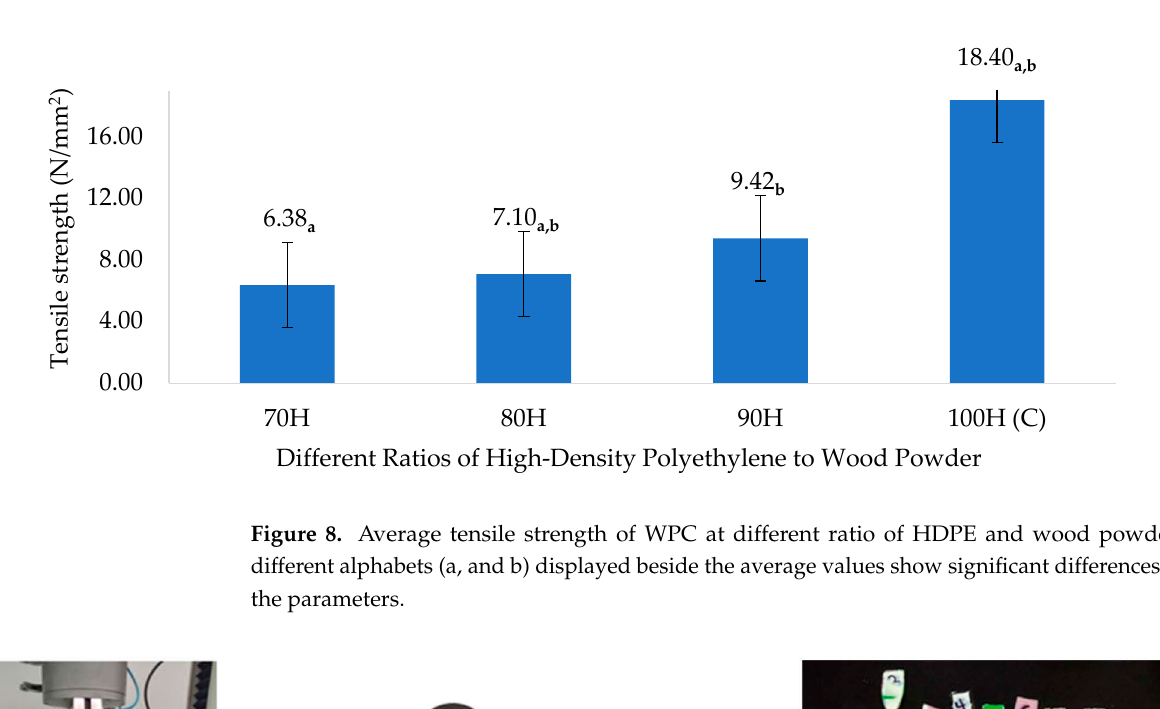
Figure 9. ( A ) Tensile strength test for ratio 100% of HDPE (100H). ( B ) Test pieces for ratio 100% of HDPE (100H) after testing.